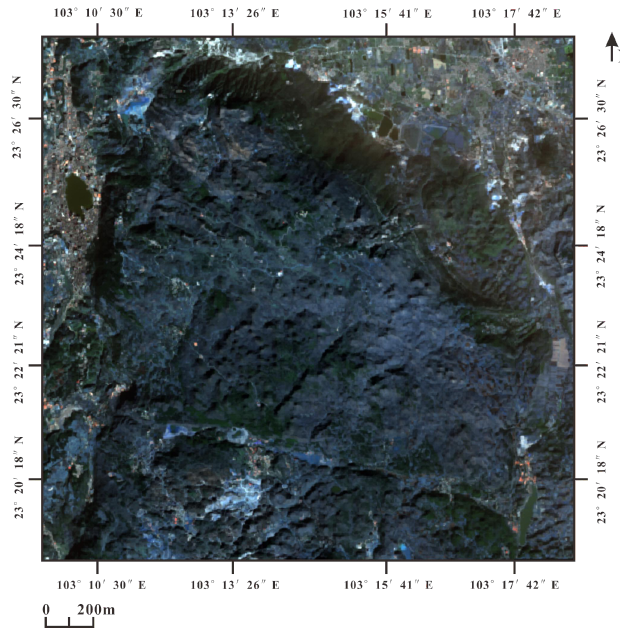
Figure 4. Landsat 8 Oli clipping image.